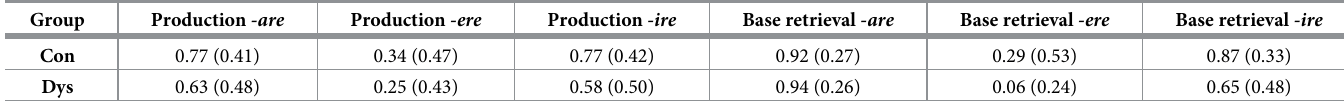
Table 9. Mean accuracy (SDs) of the two groups in tasks involving production and base retrieval in the three conjugation classes. Group Production -